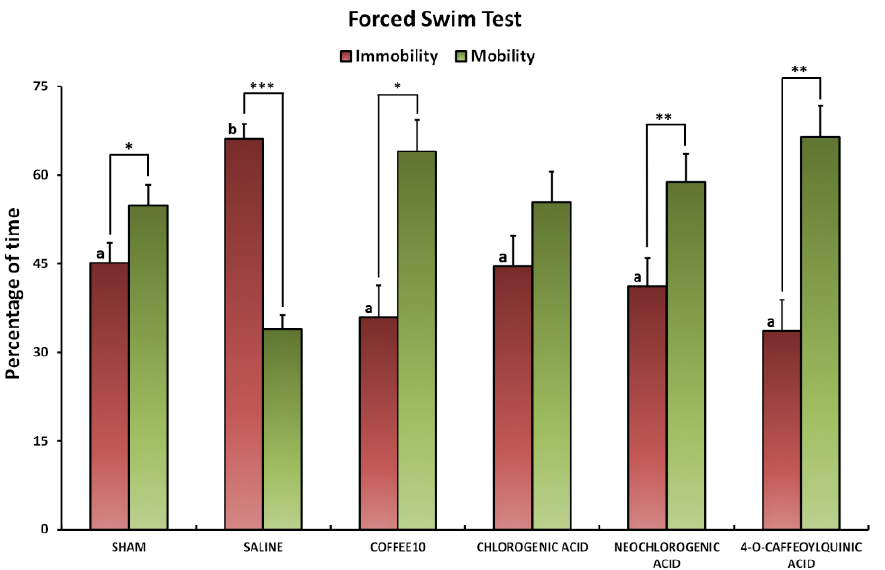
Figure 2. Effects of major coffee extract polyphenolic compounds on depression-like behavior fourteen days post-injury. Data are illustrated as mean ± SEM. a,b: not sharing a letter means significant differences in %immobility time, p < 0.05; intra-groups significant differences: *** p < 0.0001, ** p < 0.001, * p < 0.05 %immobility vs. %mobility.